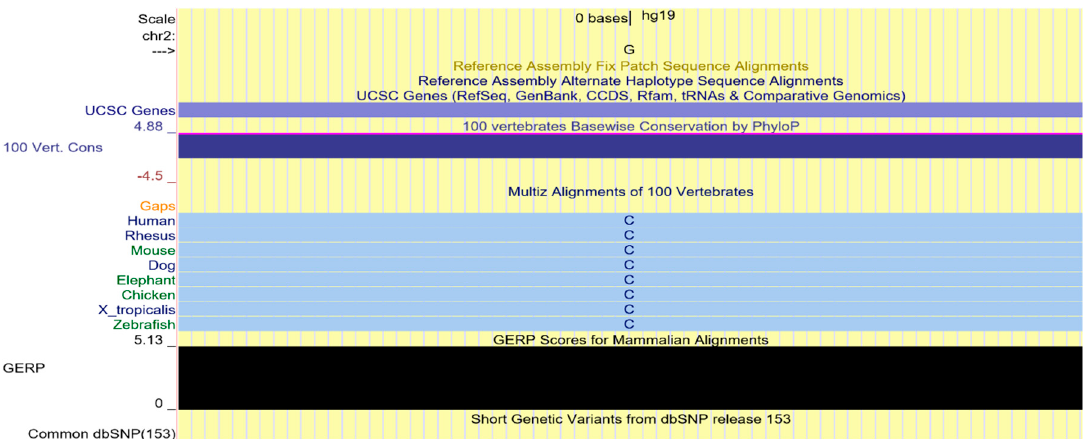
Figure 3. Multi-species alignment obtained by UCSC Genome Browser and the GERP score.